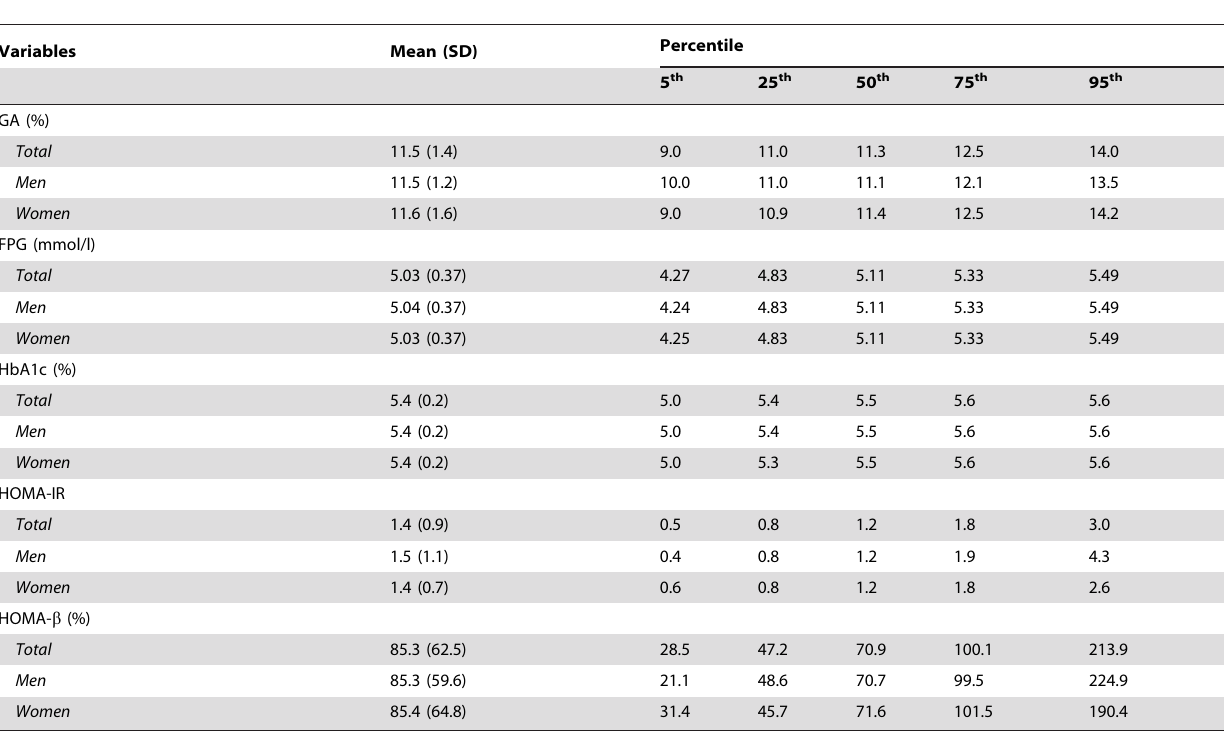
Table 2. Means and selected percentiles of GA, FPG, HbA1c, HOMA-IR and HOMA- b levels in subjects with NGT according to the sex.